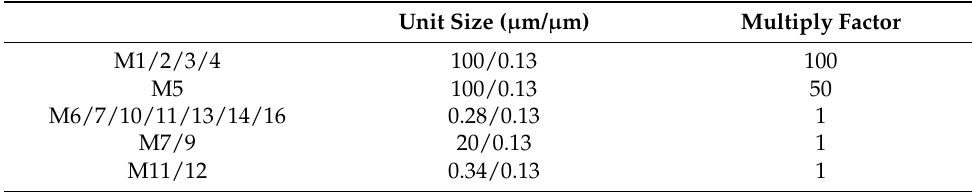
Figure 2. Schematic of the two-input common gate comparator CMP. Table 1. Circuit transistor sizes.